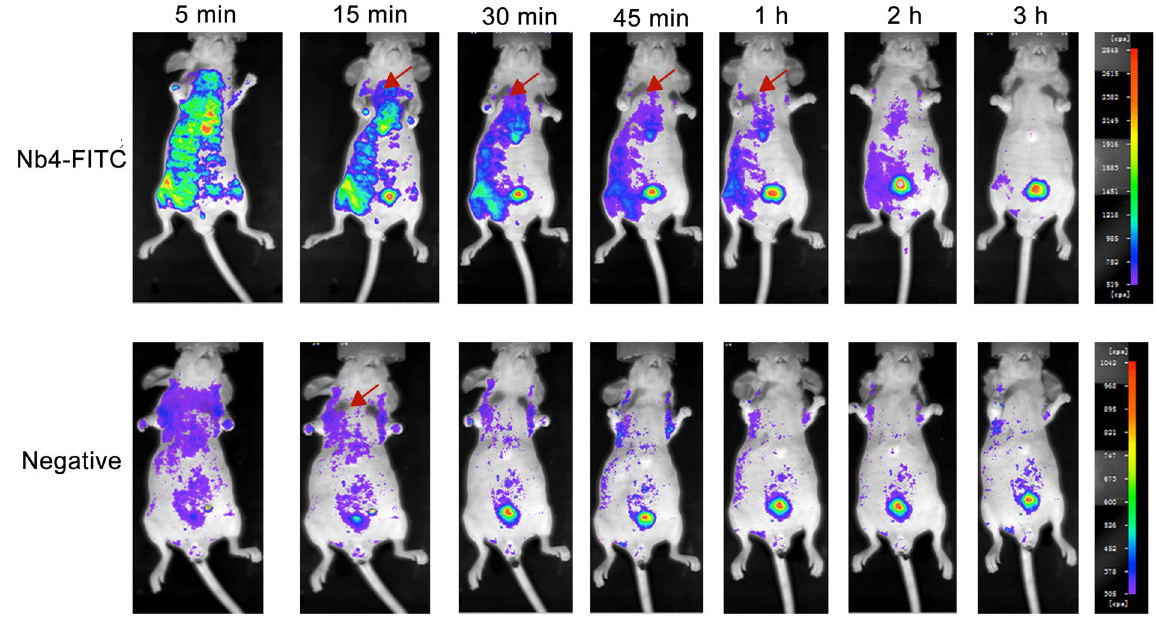
Figure 6. Distribution of Nb4 in nude mice. Nb4-FITC (10 μ L, 1 mg/kg) was injected into nude mice via the tail vein. Mice in control group were injected with an equal amount of H1N1-FITC. The distribution of Nb4- FITC and H1N1-FITC was observed at 5 min, 15 min, 30 min, 45 min, 1 h, 2 h, and 3 h after the injection under a Xenogen IVIS Imaging System (PerkinElmer, MA, USA). Red arrows are pointing to the lung.